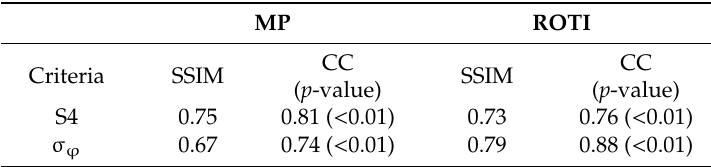
Table 1. SSIM and CC between the maps shown in Figure 5a.